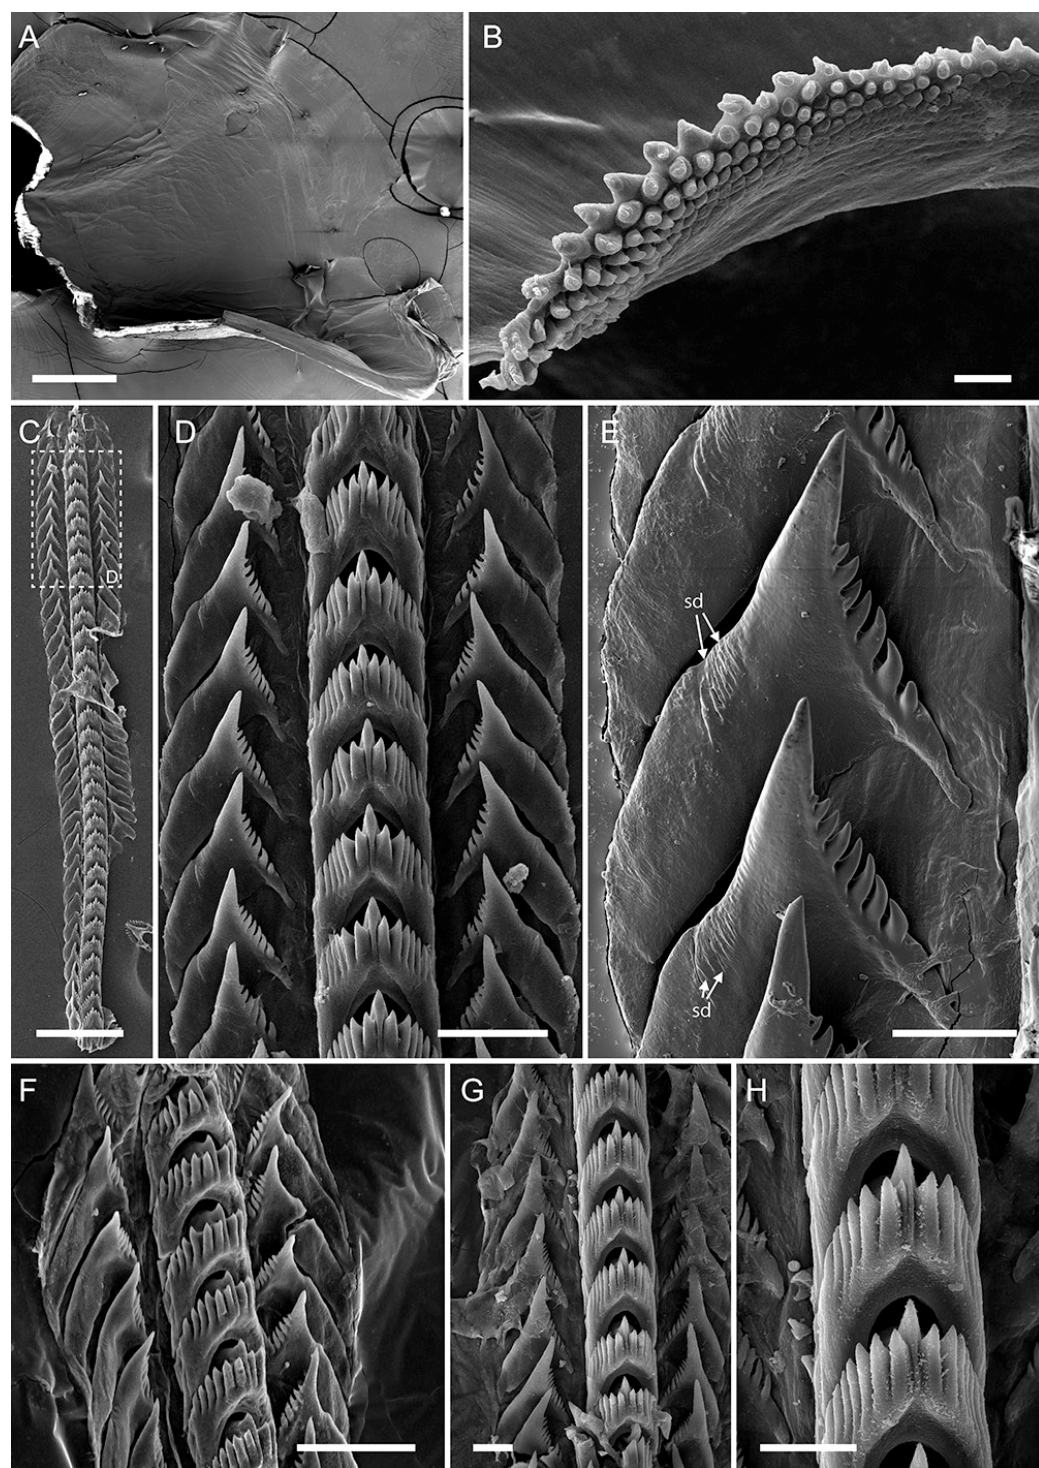
Figure 5. Coryphellina lotos, buccal armature. ( A )—IZ-L4, specimen 23 mm in length (preserved), right jaw plate. ( B )—IZ-L4, masticatory process denticulation. ( C )—IZ-L4, radula. ( D )—IZ-L4, posterior radular portion. ( E )—IZ-L4, details of lateral tooth denticulation. ( F )—IZ-T9, specimen 19 mm in length (preserved), posterior radular portion. ( G )—IZ-N42, specimen 17 mm in length (preserved), posterior radular portion. ( H )—IZ-N42, rachidian tooth. Abbreviations: sd—secondary denticles on outer side of lateral tooth. Scale bars: ( A , C ) = 200 µ m; ( B , E ) = 20 µ m; ( D , F ) = 50 µ m; ( G , H ) = 30 µ